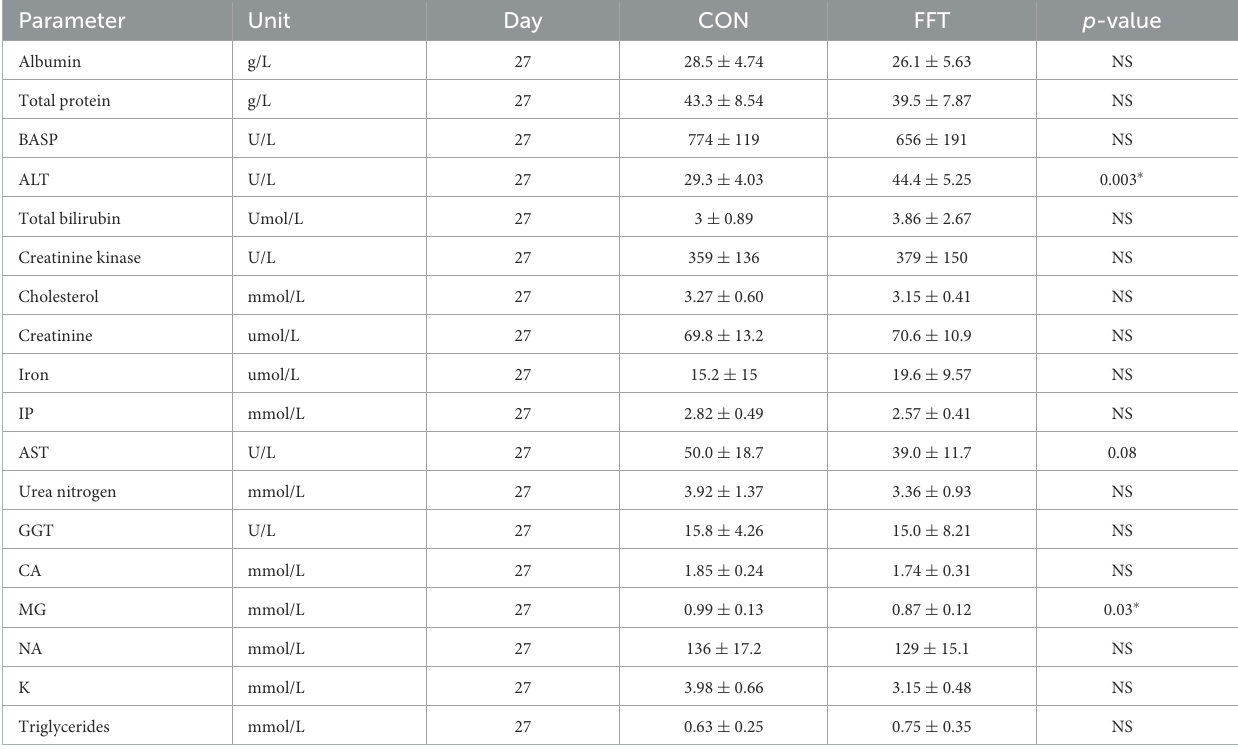
TABLE 8 Biochemistry parameters of piglets on day 27 ( n = CON: 6; FFT: